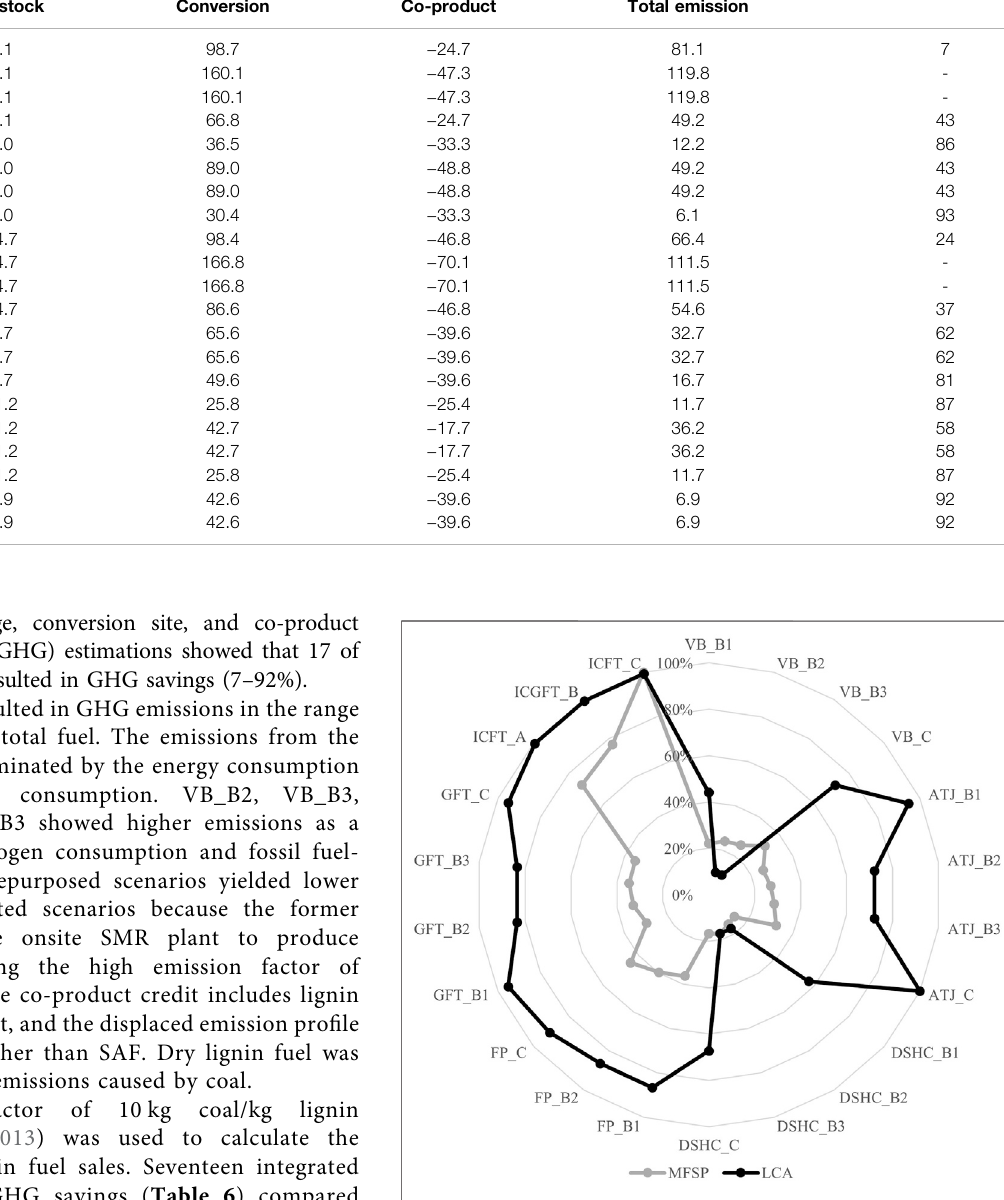
TABLE 6 | GHG emission pro fi les of the studied scenarios. Scenario Emission pro fi le, g CO 2 -eq/MJ Feedstock